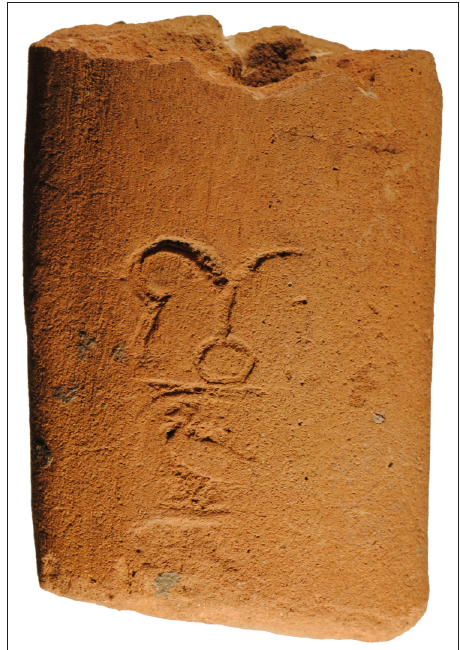
Fig. 2: British Museum GR1888,0601.738. Stamped amphora handle. Max. dim. 8.8 cm. Courtesy of the Trustees of the British Museum.